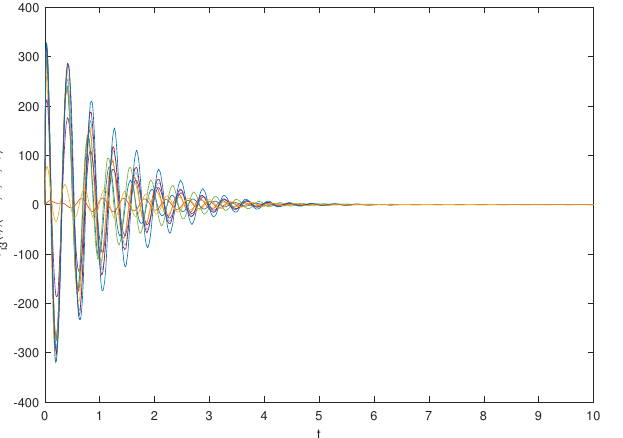
Figure 6. Synchronization errors e i 3 ( i = 1,2, · · · ,10 ) of the fractional-order system (32) and (33) with the controllers.